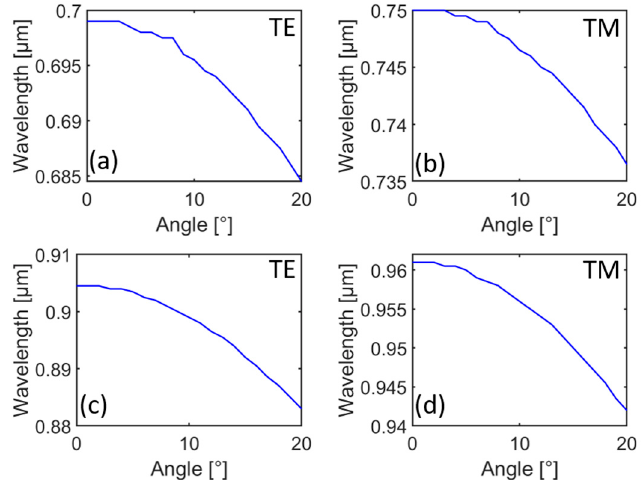
Figure 8. Peak absorption wavelength when the incident angle is varied in range 0–20°. ( a , b ) The device period p, the waveguide Ta 2 O 5 thickness t Ta2O5 , and PMMA pillars height t PMMA are fixed at 450 nm, 150 nm, and 600 nm, respectively. ( c , d ) The device period p, the waveguide Ta 2 O 5 thickness t Ta2O5 , and PMMA pillars height t PMMA are fixed at 600 nm, 150 nm, and 600 nm, respectively.